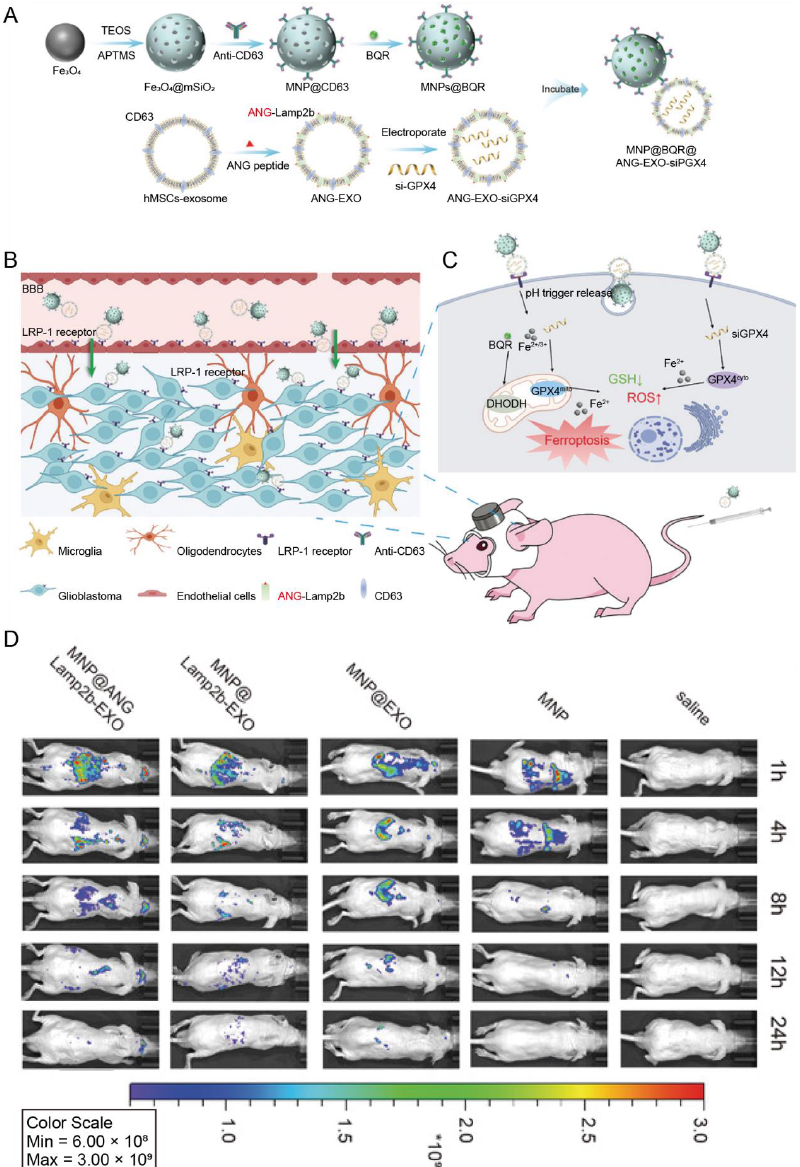
Figure 5. Mesenchymal stem cell-derived exosomes combined with magnetic nanoparticles for target- ing glioblastoma therapy. ( A ) Schematic illustration of the design and synthesis of MNP@BQR@ANG- EXO-siGPX4. ( B ) Schematic of the magnetic mouse helmet and the mechanisms of ANG peptide- mediated NPs penetrating the BBB and accumulation in tumors. ( C ) Mechanisms that induce ferroptosis in glioblastoma (GBM) cells. ( D ) In vivo distribution of saline, MNPs, MNP@EXO, bearing mice at 24 h postinjection. TEOS, silicon tetraacetate; APTMS, (3-aminopropyl)